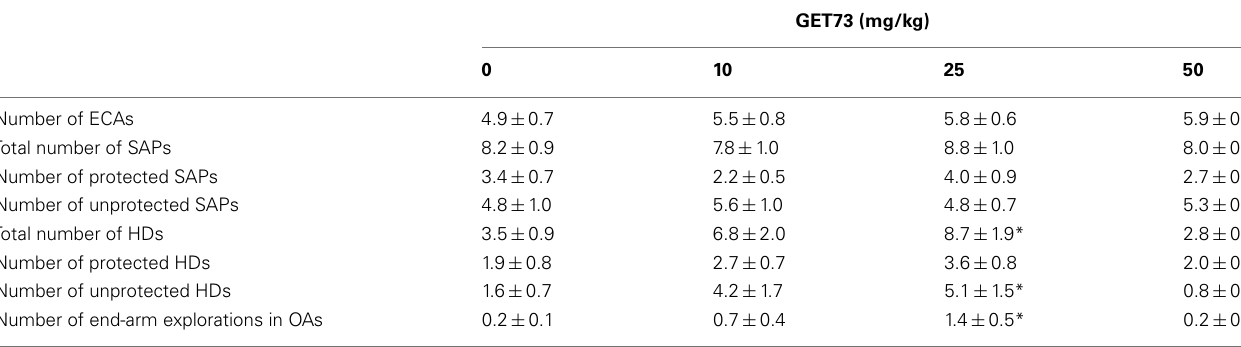
Table 5 | Effect of theacute, intragastric administration of different doses of GET73 on a series of variables measured in Sardinian alcohol-preferring (sP) rats exposed to the elevated plus maze (EPM) test.